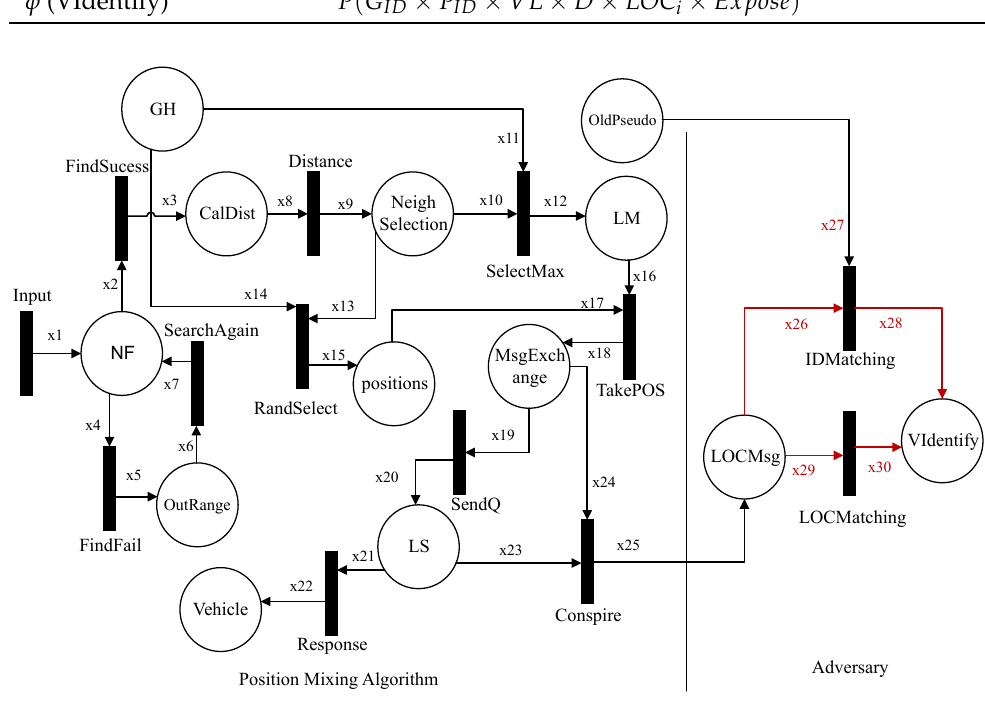
Figure 13. HLPN of position-mixing algorithm. The neighbor function is used to find transmission range neighbors in the vicinity of a vehicle. Equation (42) shows the success of finding neighboring vehicles and ready to cal- culate distance among neighboring vehicles. However, the search may be unsuccessful due to the vehicle falling out of range of a group as specified in Equation (43). In Equation (44), the target vehicle will try again to search for vehicles in the transmission